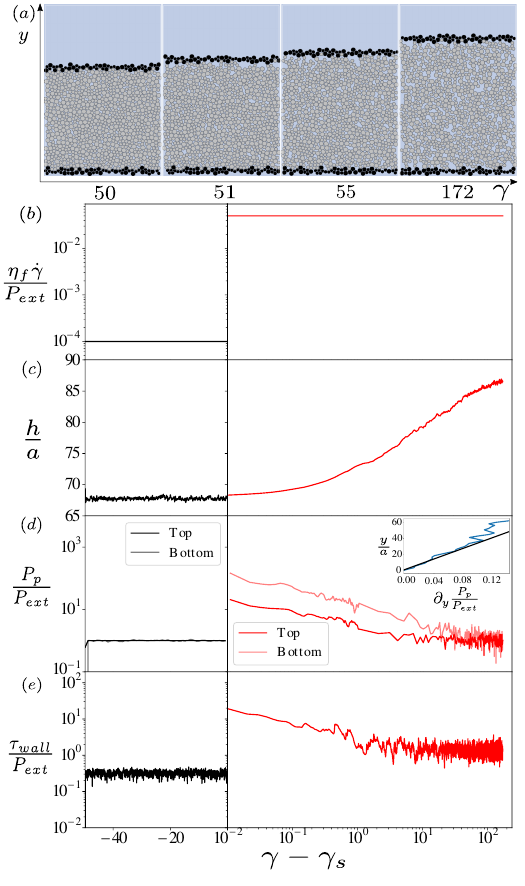
Figure 3. Step increase of J ext = η f ˙ γ/ P ext from steady state at J ext = J i = 1 × 10 − 4 (black curves) to J ext = J f = 5 × 10 − 2 (red curves) at a strain γ s = 50. (a) Snapshots of the system at dif- ferent strain values after the increase of J ext . The voids below the top wall at γ = 51 and γ = 55 show that dilation occurs ini- tially below the top wall, and at later strains spreads throughout the entire height. (b) Applied J ext as a function of strain γ . (c) Height h as a function of γ , showing the slow dilation of the sys- tem over more than 100 strain units to reach steady state at J f . (d) Dimensionless particle normal stress measured at the bottom (light colored) and top (dark colored) of the sample, as a function of γ . In inset, the gardient of P p as a function of height obtained at γ − γ s = 0 . 02. (e) Macroscopic friction coe ffi cient at the top wall as a function of γ .